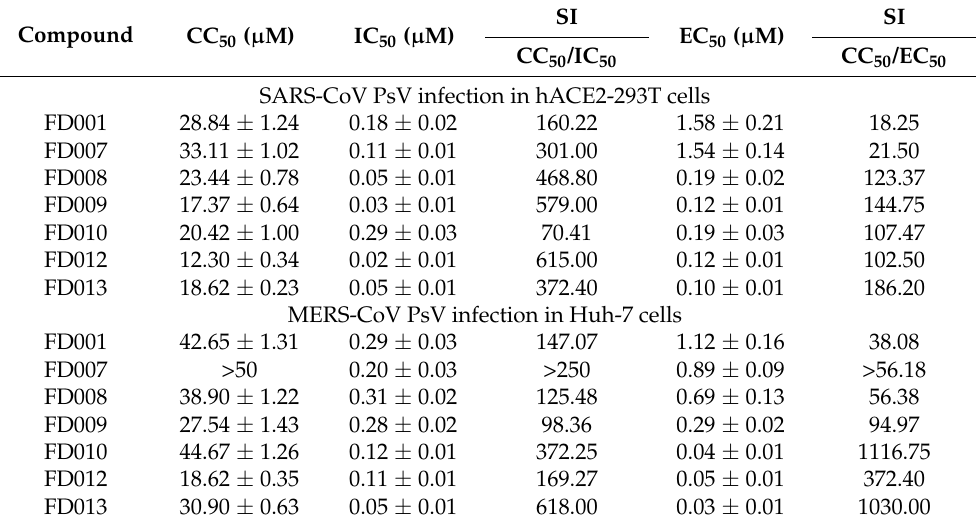
Table 2. Antiviral activity of FD001 and its analogs against SARS-CoV and MERS-CoV PsV infection.